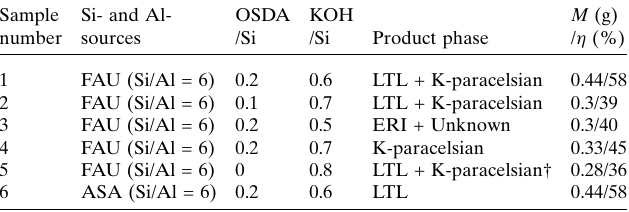
Table 1 Summarized product phases for the synthesis system FAU–OSDA–KOH. Sample Si- and Al- number